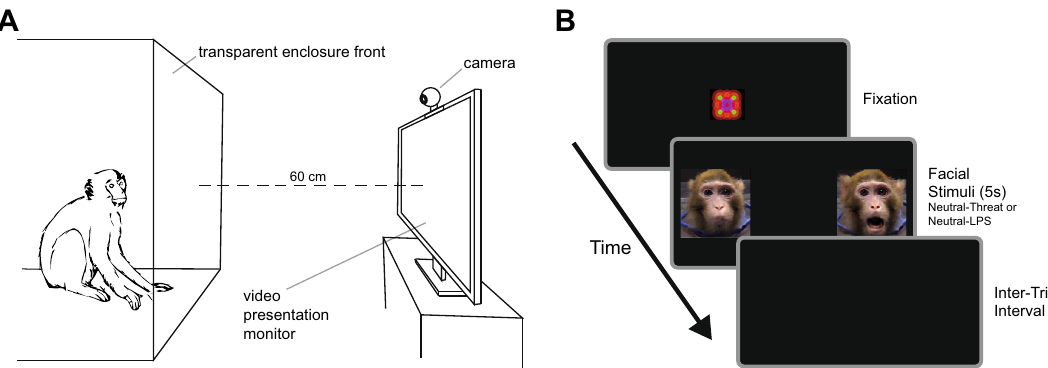
Figure 1. ( A ) Schematic illustration of the attention bias task set-up. ( B ) Illustration of a trial in the attention bias task. An experimenter triggered the appearance of fixation and facial stimuli screens when the subject looked towards the